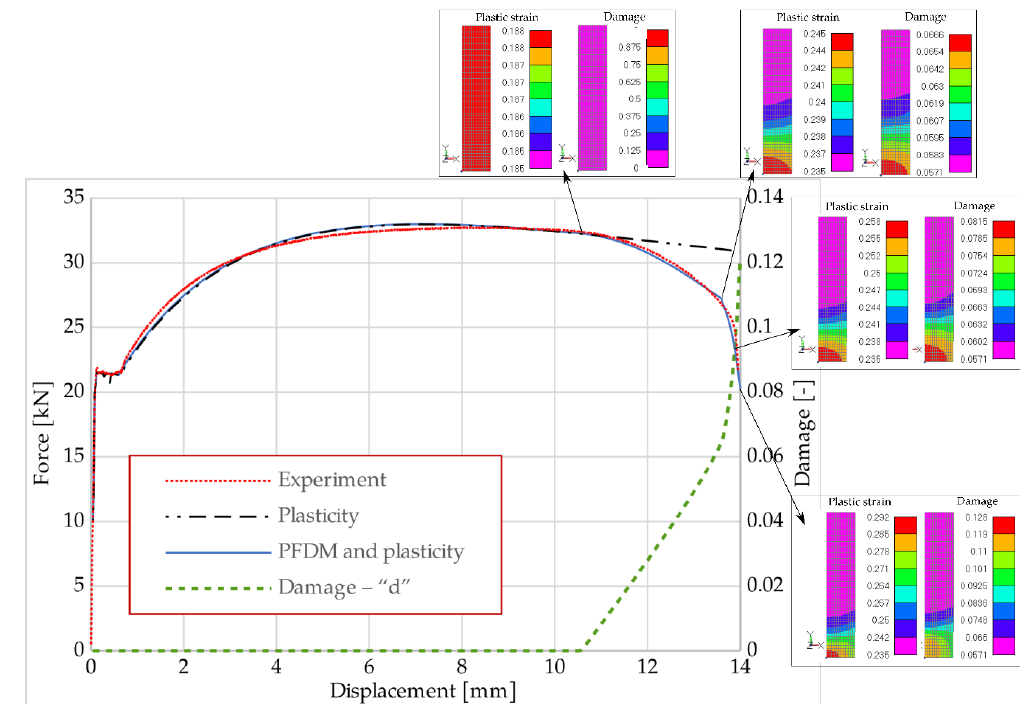
Figure 14. Force–displacement response of experiment and simulations vs. maximal damage value for S355J2+N steel specimens.